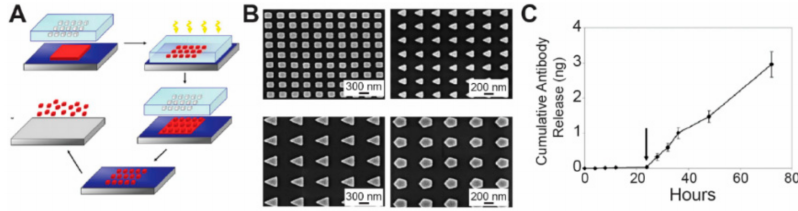
Figure 4. Nanoimprint lithography (NIL) techniques were used to generate micro/nanoparticles with controllable features for therapeutic delivery to cells. ( A ) NIL relies on printing a mold onto a layer of photo or thermal materials. UV light was used to transform the materials into a solid shape. The residual materials during printing will connect the nanoparticles together and thus require reactive ion etching techniques to remove the residual layer, generating isolated nanoparticles [131]; ( B ) NIL based techniques were able to generate nanoparticles with different shapes. Four shapes were illustrated in this work [130]; ( C ) The NIL-based nanoparticle production techniques allow the cumulative release of therapeutic cargos. These techniques also allow the loading of smart materials (i.e., enzyme triggered materials), thus the cargos can be released in a certain enzyme environment [130], with copyright permission from ©